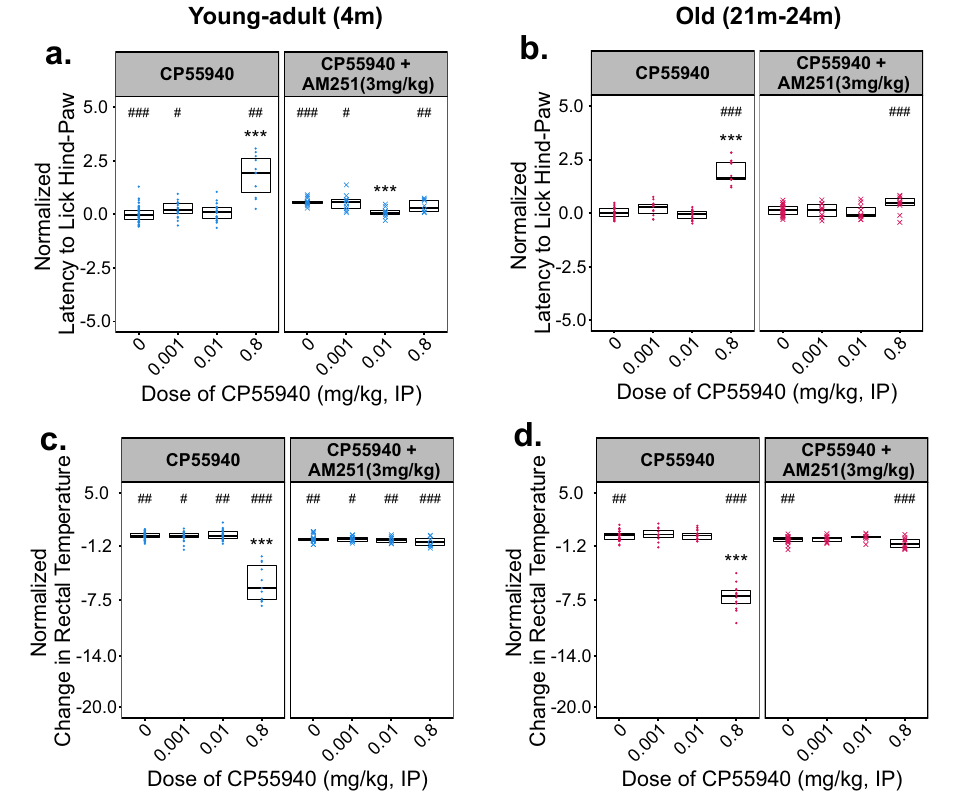
Fig. 3 Effects of CP55940 co-administered with the CB1 inverse agonist AM251 on nociception and thermoregulation in young – adult (4 m) and old (22 m) male C57BL/6 mice. Varying doses of CP55940 were administered alone or in a pre-mixed solution with 3 mg/kg of AM251 to young – adult and old male mice. a , b Latency to lick the hind-paw of young – adult ( a ) and old ( b ) male mice when tested on the hot plate 60 m after drug injection. c , d Change in rectal temperature of young – adult ( c ) and old ( d ) male mice 60 m after drug injection. All data have been normalized to the responses of vehicle-treated age-matched control animals which were tested at the same time. Individual data points for each testing group are overlaid on Tukey-style boxplots. The lower and upper edges of each box represent the fi rst and third quartiles, respectively. The middle horizontal line in each box depicts the median of that dose/age group. Sample sizes for every treatment group and fi gure panel are listed in Supplemental Fig. 5. Signi fi cant omnibus results were followed by planned post hoc contrasts of each dose vs. vehicle-treated control groups using Dunn ’ s method. The false discovery rate was corrected for using the Benjamini, Hochberg, and Yekutieli method. Within an age group, signi fi cant differences ( P < 0.05) between a given dose and the vehicle-treated response (0 dose) are indicated using asterisks (*). Differences between CP55940 alone and CP55940 + AM251 at a given dose are indicated by pound signs (#).